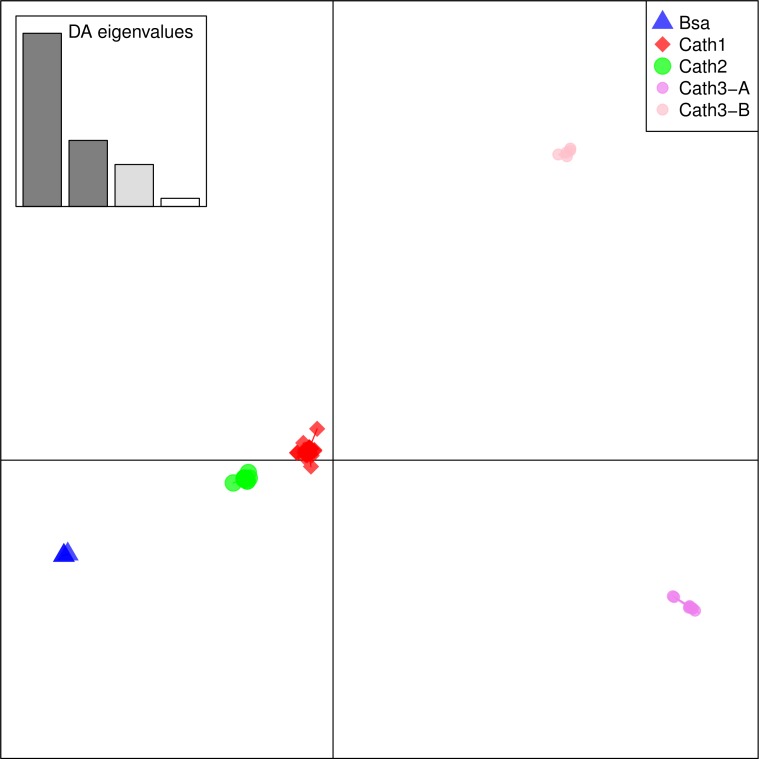
Discriminant Analysis of Principle Components (DAPC) scatterplot of the five allele clusters.Ten principle components and three discriminant functions were retained in the analysis. Scatterplot of the first two disciminant functions with eigenvalues used in black. The alleles are represented as dots of different shapes and colors representing the a priori groups Bsa (Boreogadus saida), and the Cath1, Cath2, Cath3-A and Cath3-B clusters of Fig. 2.